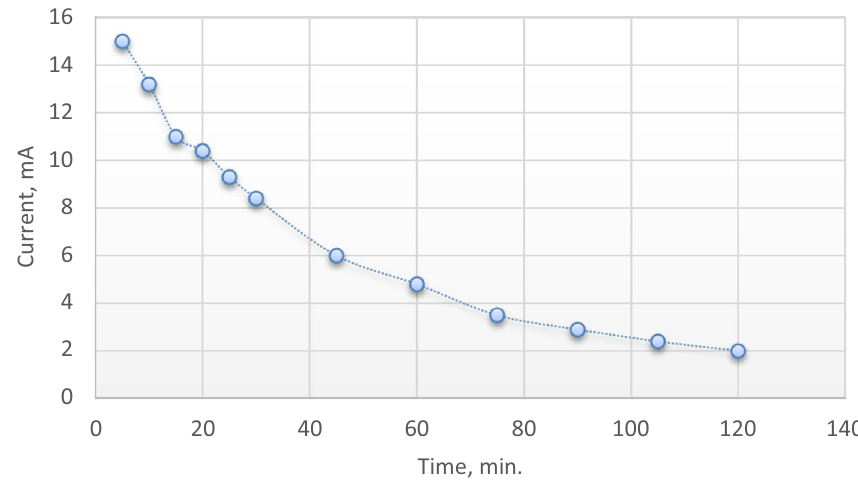
Fig. 6 Current change over time of a flexible textile battery with 22Ω load